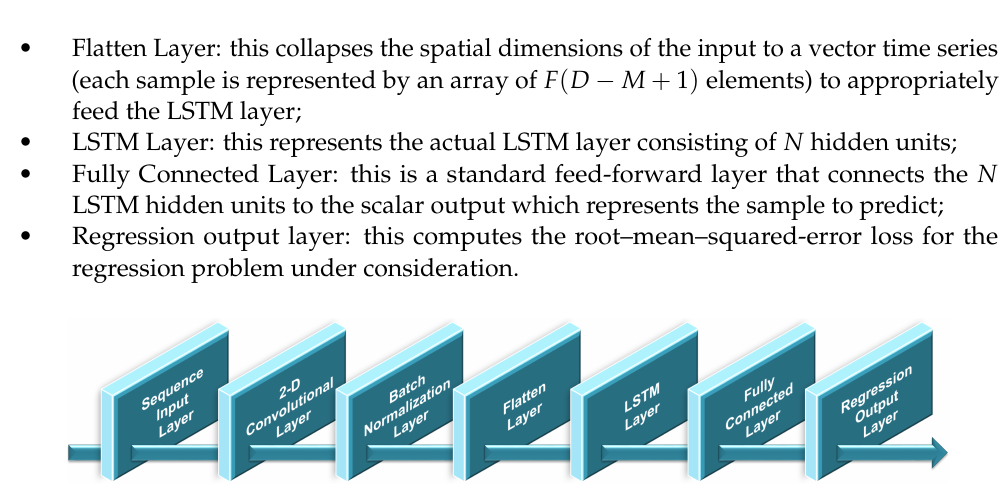
Figure 2. Architecture of the proposed deep neural network for multivariate prediction.